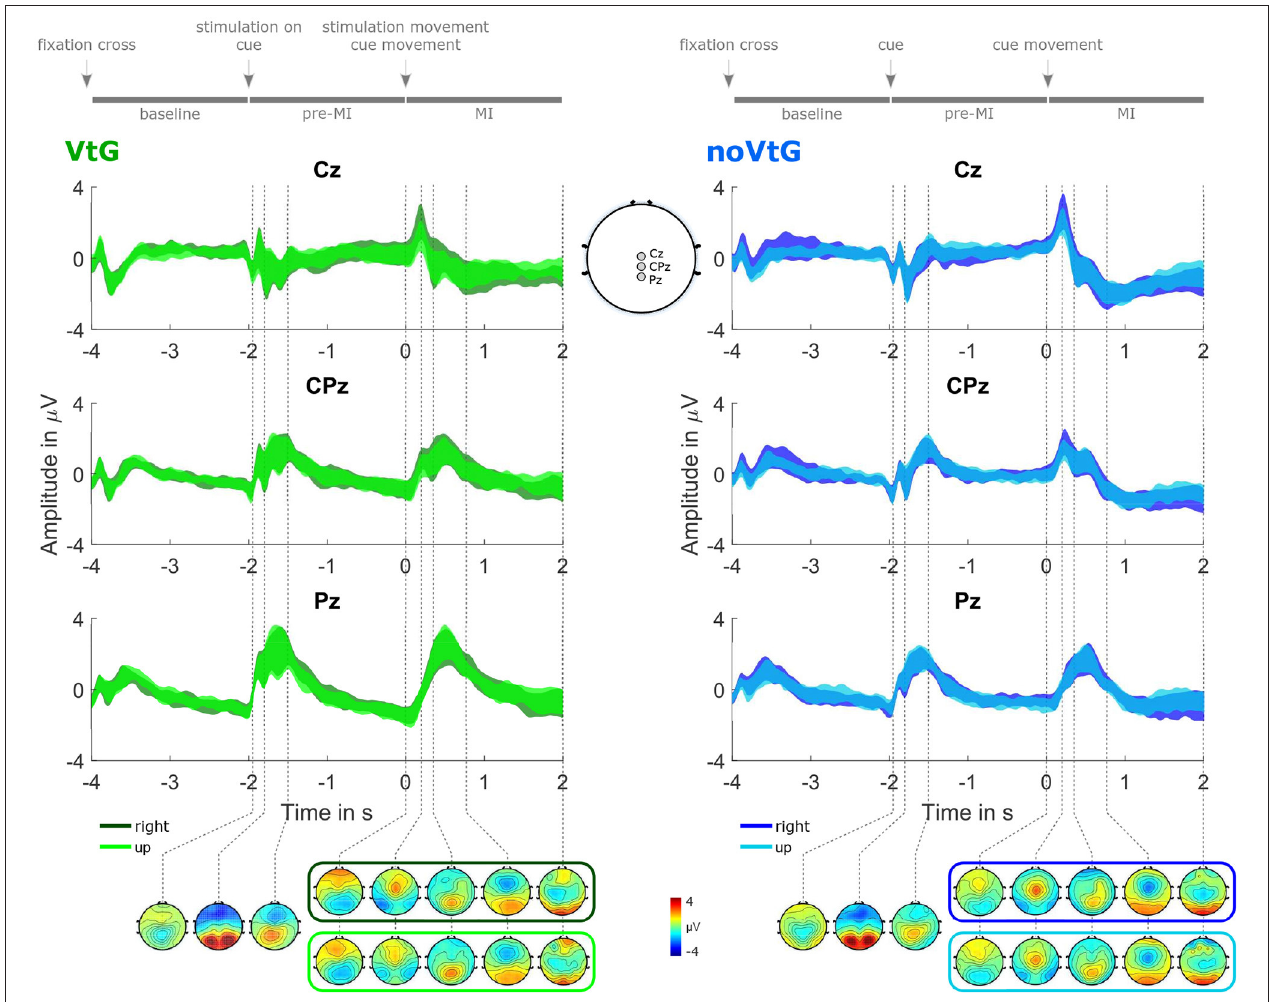
FIGURE 3 | Grand-average potentials (0.2–5 Hz), for each condition, and direction. The potentials are represented as 95% confidence intervals of the amplitudes at Cz, CPz, and Pz, complemented by topographic plots at selected time points. The left panel depicts the potentials for condition VtG, whereas the dark green trace corresponds to the direction right, and the light green trace to the direction up, respectively. Similarly, in the left panel, the potentials for direction right are shown in dark blue, and the potentials for direction up in light blue. For time points before the cue movement onset, one set of topographic plots per condition is presented, while for time points after the cue movement onset, one set per condition and direction is presented. These plots are framed with a color-coded frame matching the color of the amplitude traces of the corresponding direction. The sketch in the middle at the bottom highlights the electrode positions whose amplitude traces are shown at the